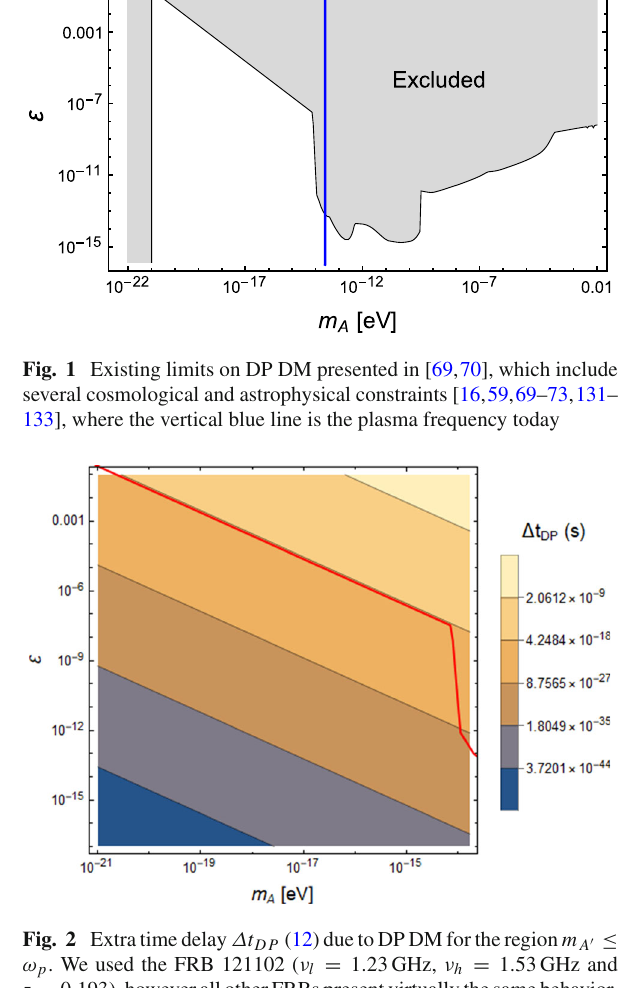
ν = 1 . 23GHz, ν = 1 . 53GHz and l h